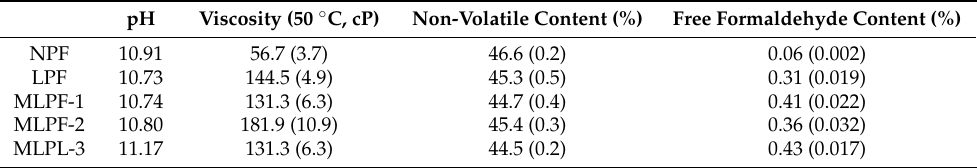
Table 2. Basic properties of the adhesives.